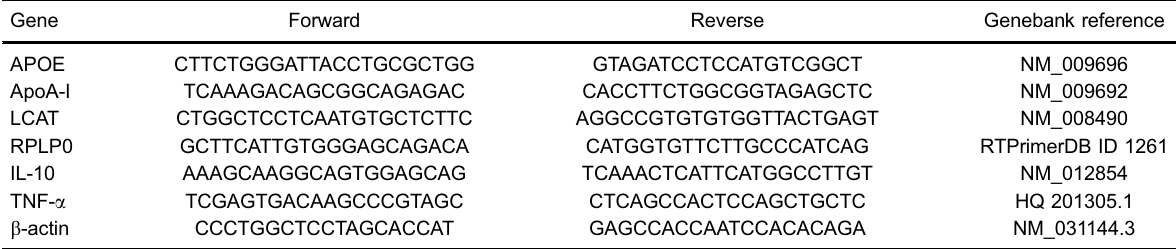
Table 3. Primers used for the RT-qPCR